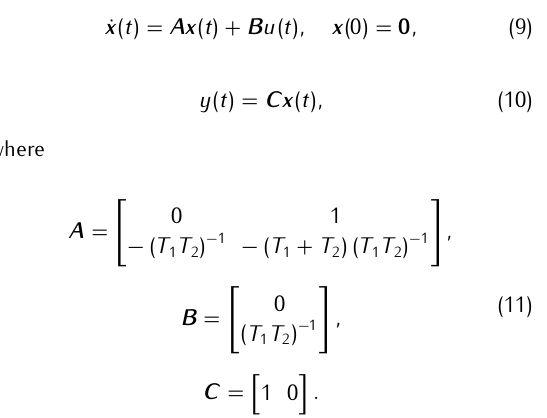
potentiometer and it provides a continuous resistance out- put proportional to the fuel level in the tank. If the tank is full, the sensor shall provide the control module with resistance of 100Ω. If the tank is empty, the sensor shall provide the resistance of 0Ω. The control module shall fil- ter the input signal ( FuelLevelSensor ) and then transmit the filtered value ( FuelLevelValue ) to the IPC via the CAN (Controller Area Network) bus [19] that is responsible for fuel level indication to the driver. The filtered value is the result of the following calculation: